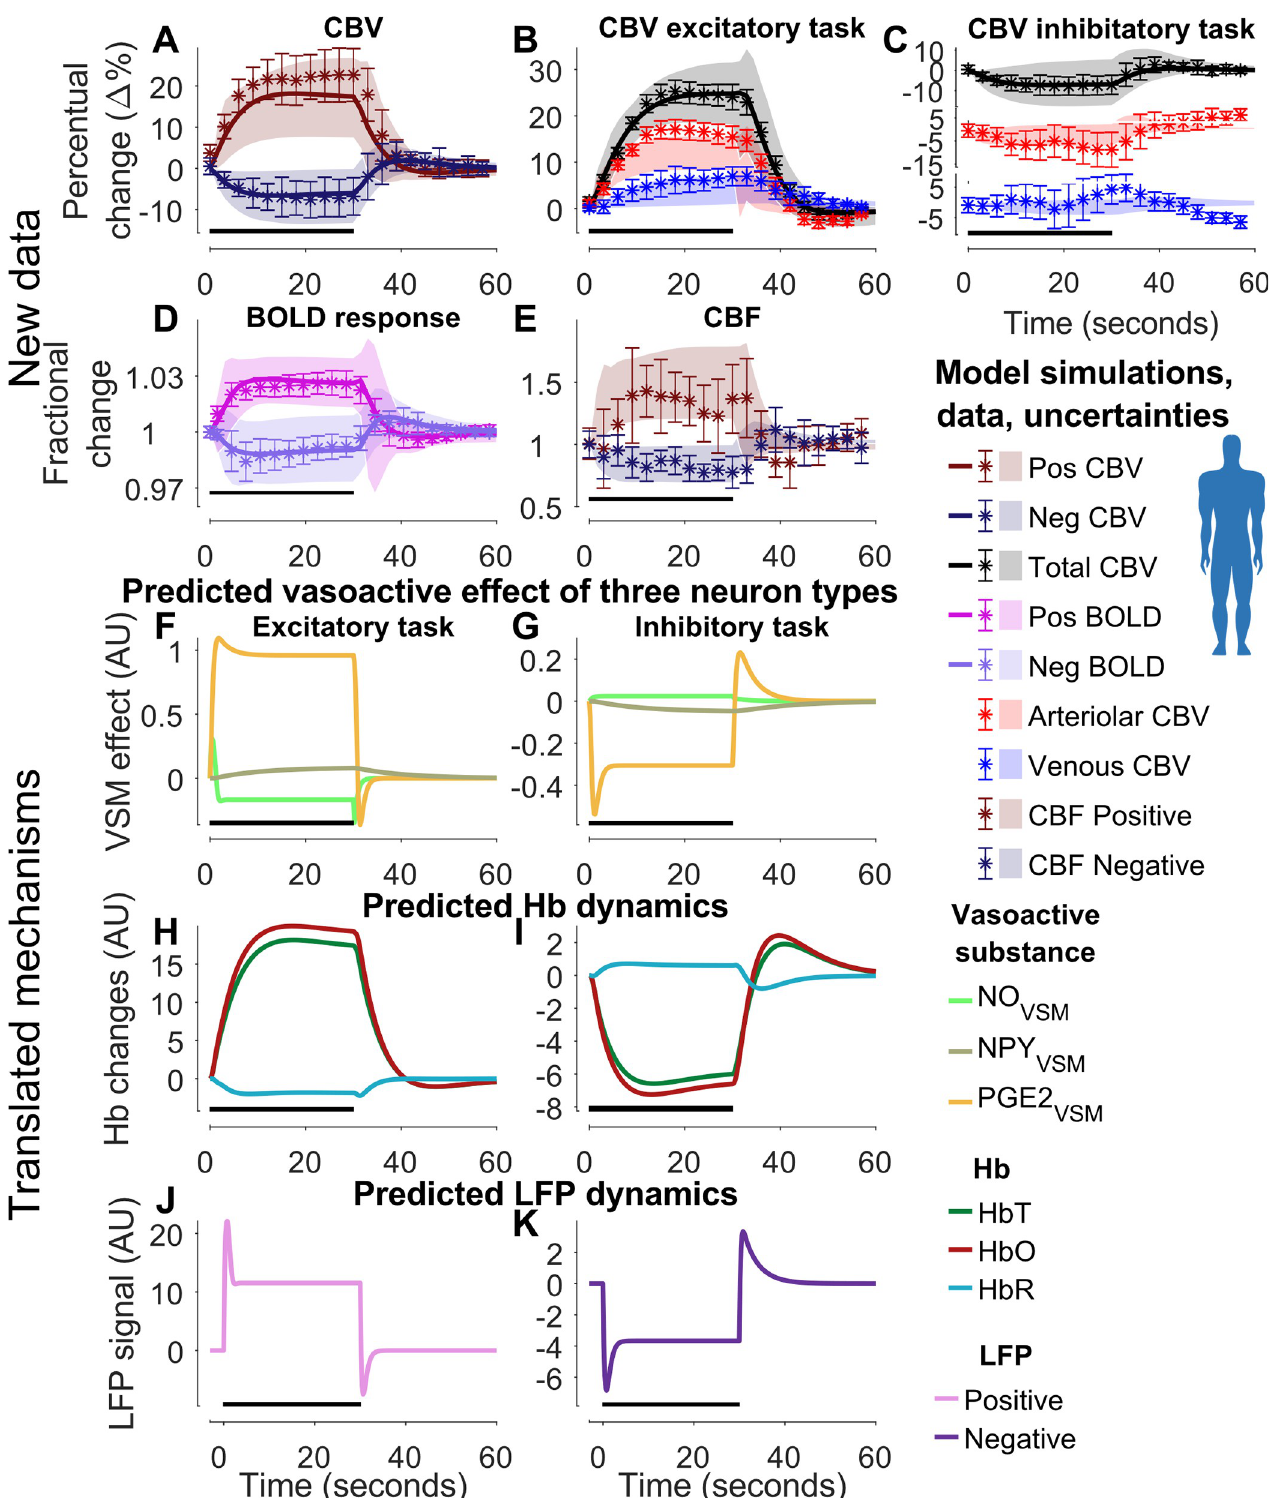
Fig 7. Model estimation and prediction of MR-based experimental data in humans for different visual stimulation tasks (Section 2.3). The graph contains data for three different tasks: cerebral blood volume (CBV) (A), blood oxygen level dependent (BOLD) signal (D), and cerebral blood flow (CBF) (E) changes for small flickering checkerboard task, and compartment-specific CBV changes for an excitatory (B) and inhibitory (C) flickering tasks. For each graph, the